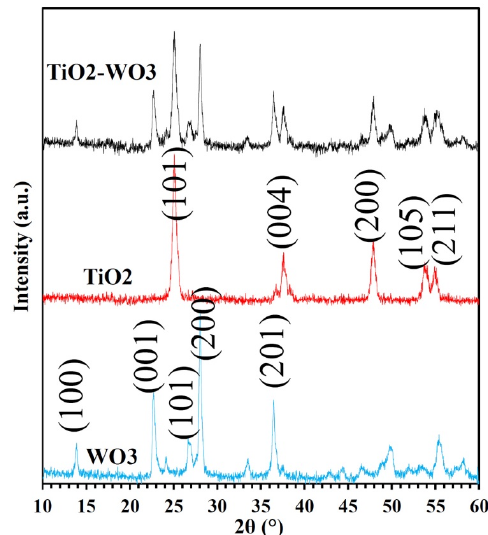
Fig. 1. XRD patterns of the prepared